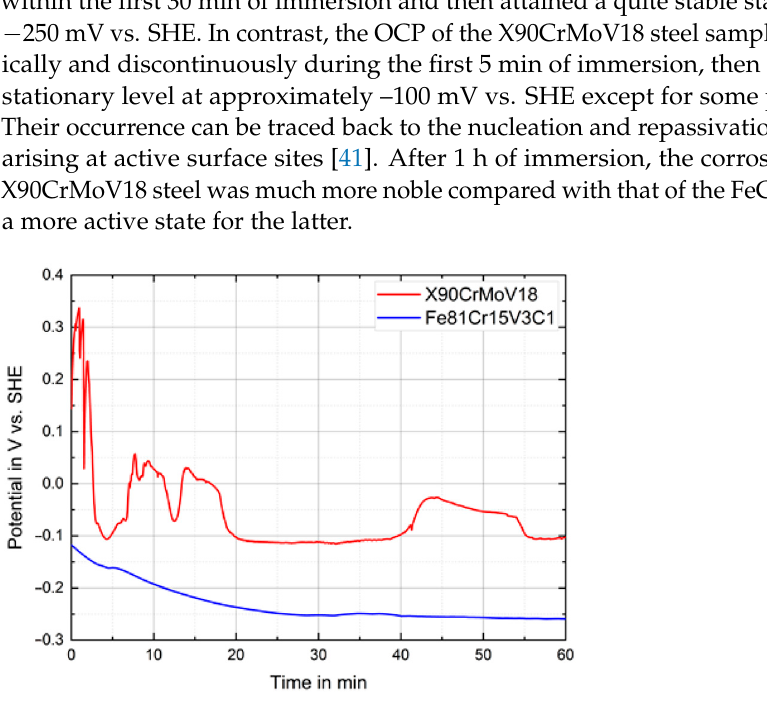
Figure 7. Open circuit potential transients for the novel cast steel Fe81Cr15V3C1 and the reference steel X90CrMoV18, measured in 3.5 wt % NaCl solution at room temperature.